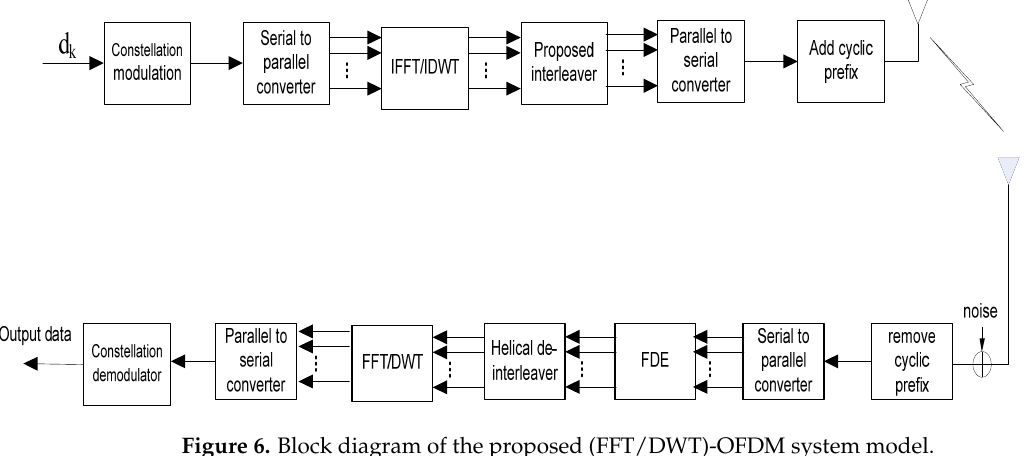
Figure 6. Block diagram of the proposed (FFT/DWT)-OFDM system model.